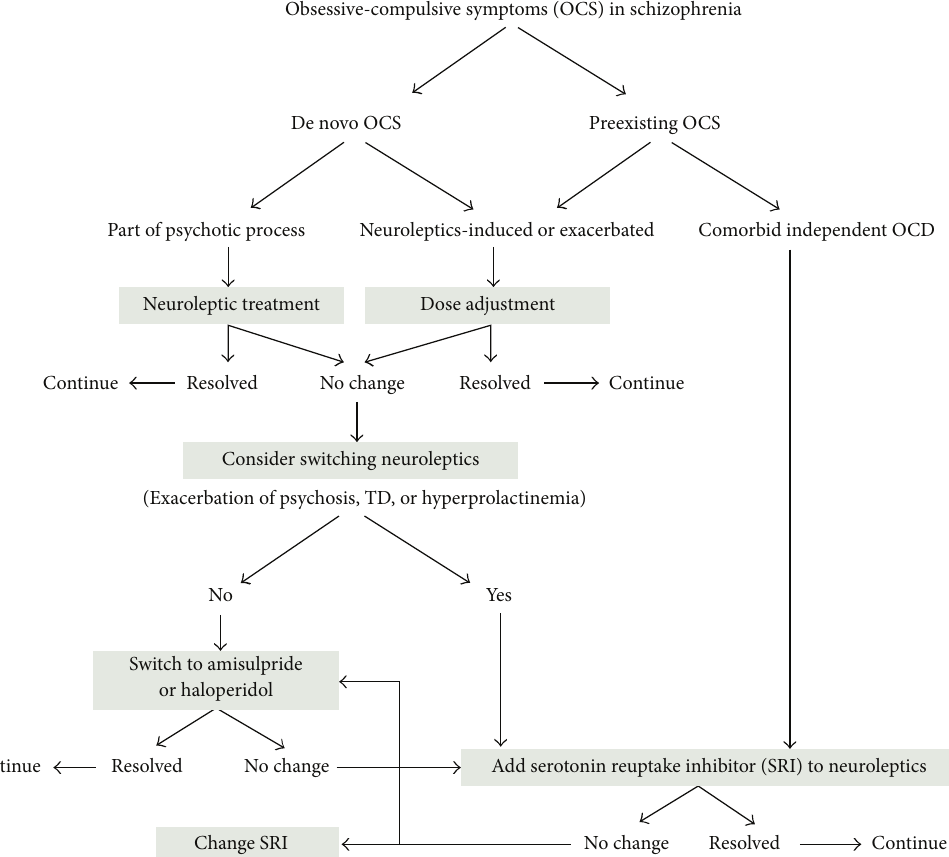
Figure 1: Algorithm of OCD/OCS management in schizophrenia. (Adapted from [7]. Adapted with